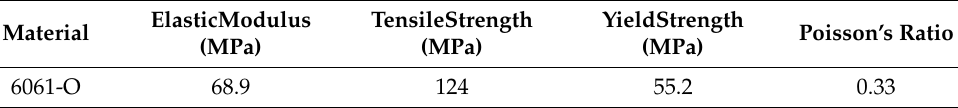
Figure 7. Displacement dependent variation for stress of the specimen.